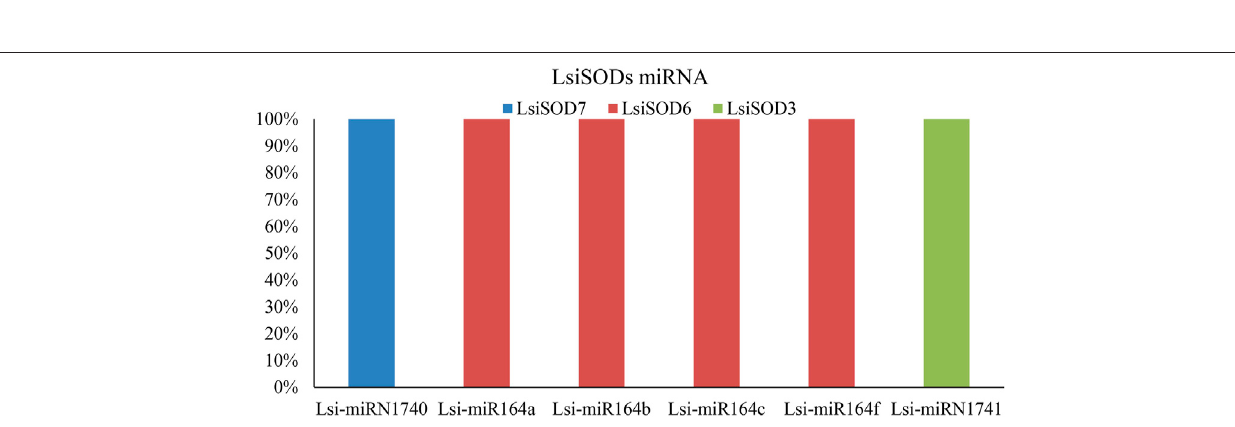
Frontiers in Genetics |